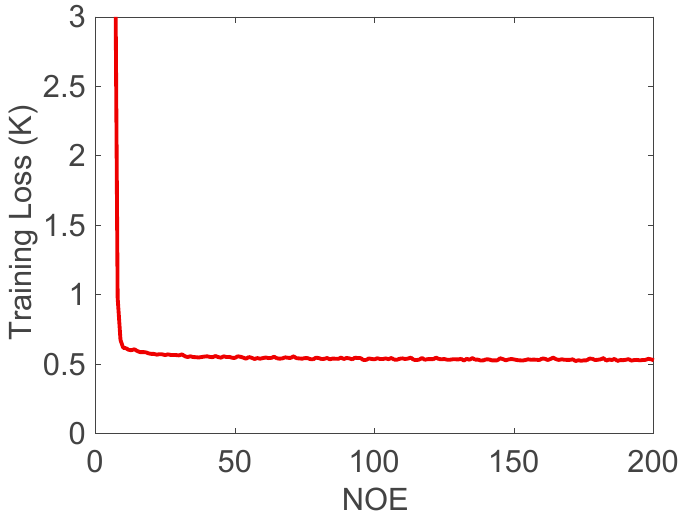
Figure 9. Training loss as a function of NOE (number of epoch). Here the loss function is based on all 26 pairs of MODIS LST and resampled Landsat LST scenes.